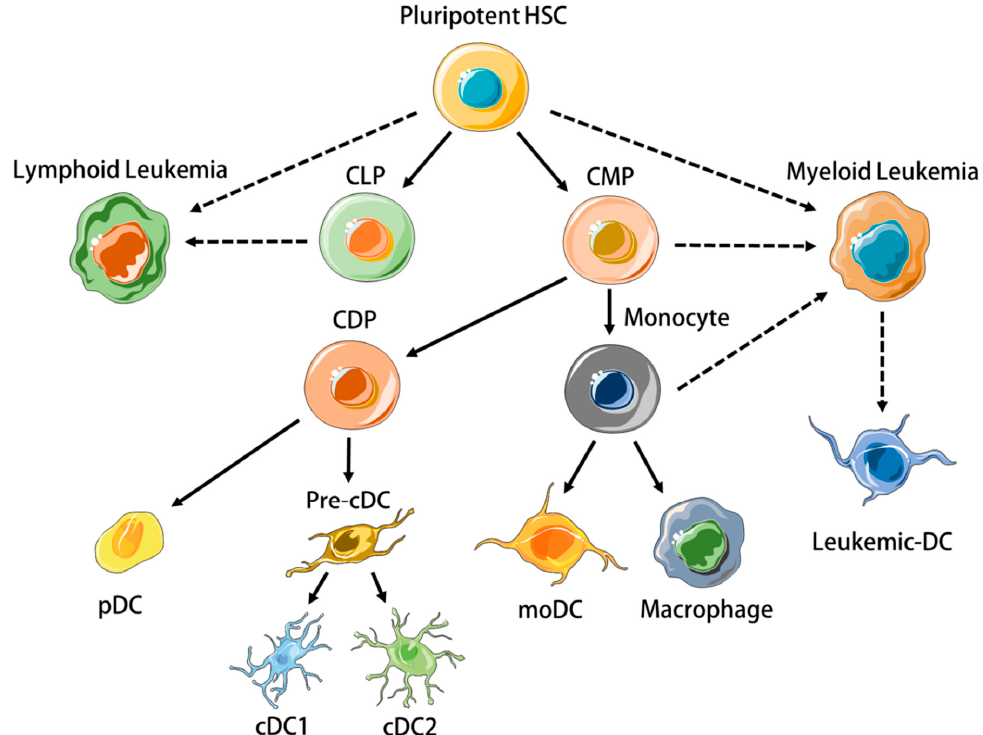
Figure 1. Plasmacytoid, conventional, and monocyte-derived dendritic cells (DCs) differentiate from distinct progenitors. Oncogenic mutations in hematopoietic progenitor cells may result in their clonal proliferation and the pathogenesis of leukemia. Leukemic myeloid cells may differentiate into cells with DC properties (Leukemic-DCs). HSC = Hematopoietic Stem Cell, CLP = Common Lymphoid Progenitor, CMP = Common Myeloid Progenitor, CDP = Common Dendritic Cell Progenitor, pDC = plasmacytoid DC, cDC = Conventional DC, moDC = monocyte-derived DC. Cellular art modified from Servier medical art repository under Creative Commons Attribution 3.0 Unported License https://creativecommons.org/licenses/by/3.0/legalcode. Leukemias are neoplastic disorders characterised by the clonal proliferation of immature immune cells in the bone marrow (BM) [13]. They are classified as ‘myeloid’ or ‘lymphoid’, depending on the cell precursor from which they originate (Figure 1) [14,15]. As with solid tumors, disease progression occurs despite endogenous immune responses to leukemic cells [16]. The